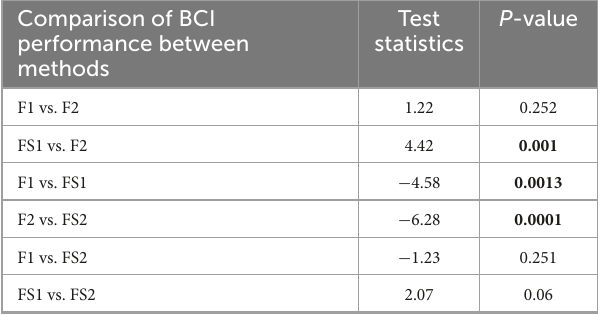
TABLE 1 Results of the post-hoc comparison of BCI performance achieved with four feature extraction and selection methods for SVM classifier and SEP10 averaging option.